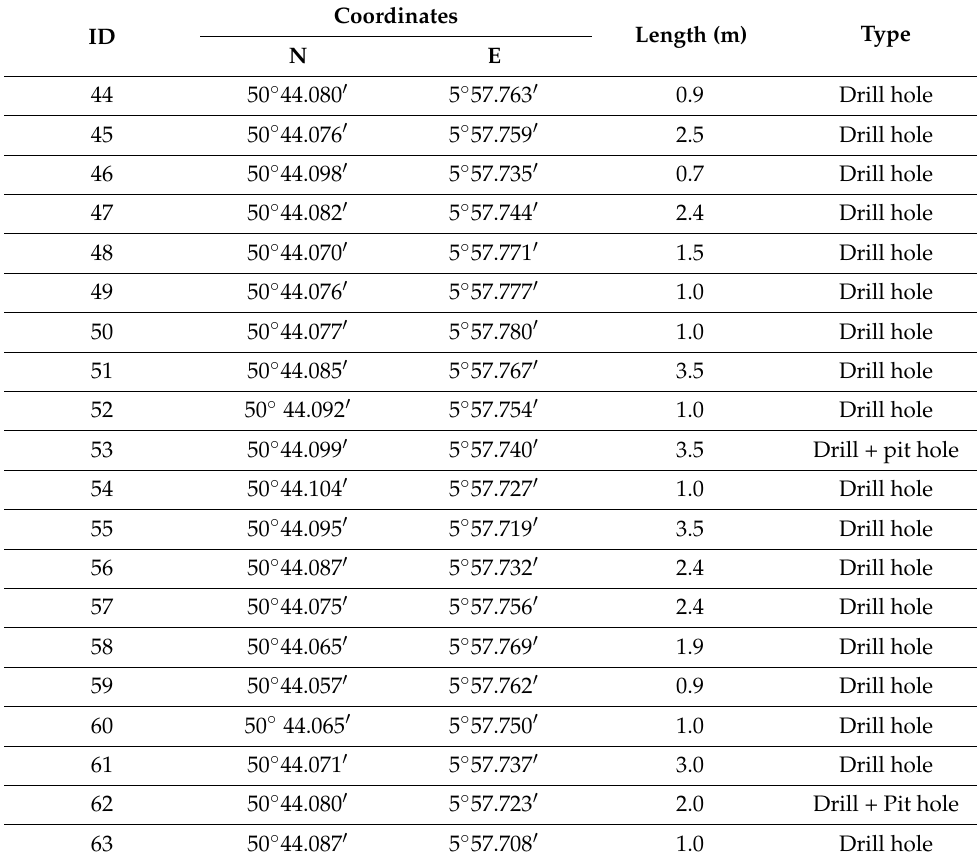
Table 2. Information about the location, depth and type of